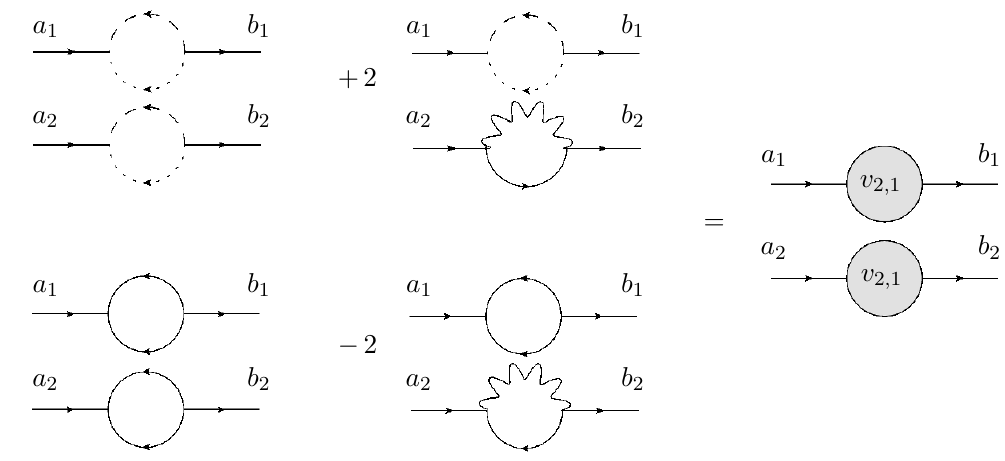
Figure 5 . The simultaneous corrections to two scalar propagators in the di(cid:11)erence theory can be expressed in terms of the one-loop correction. The factor of 2 in front of the diagrams with the vector (cid:12)eld propagator is a multiplicity